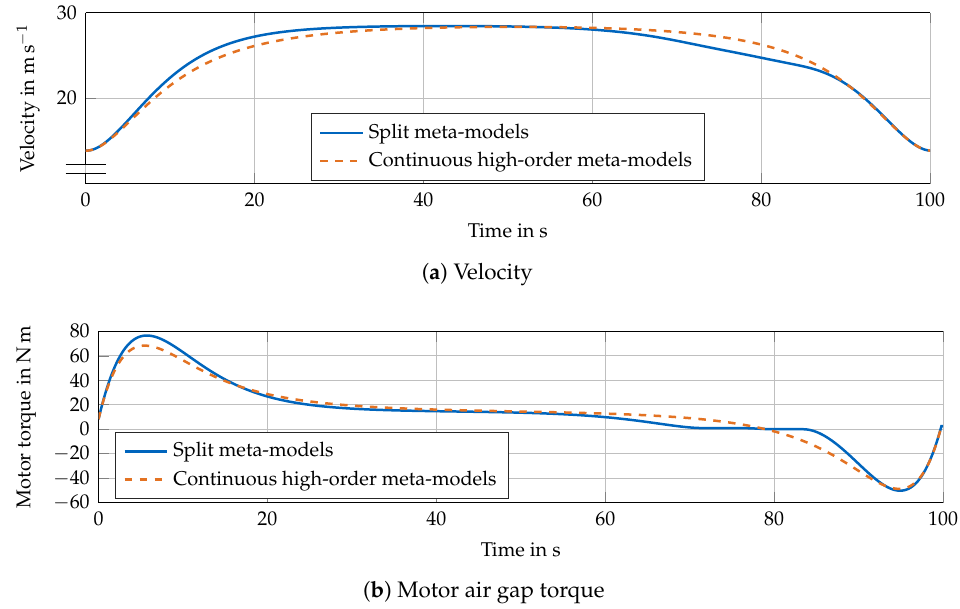
Figure 9. Comparison of ( a ) speed profiles and ( b ) corresponding motor torque during the city-to- city-scenario for split and continuous high-order